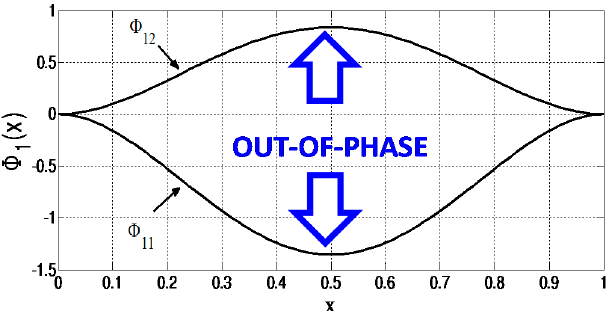
Figure 10 . The first coupled mode shape of the double-microbeams case assuming V DC = 2 Volt.